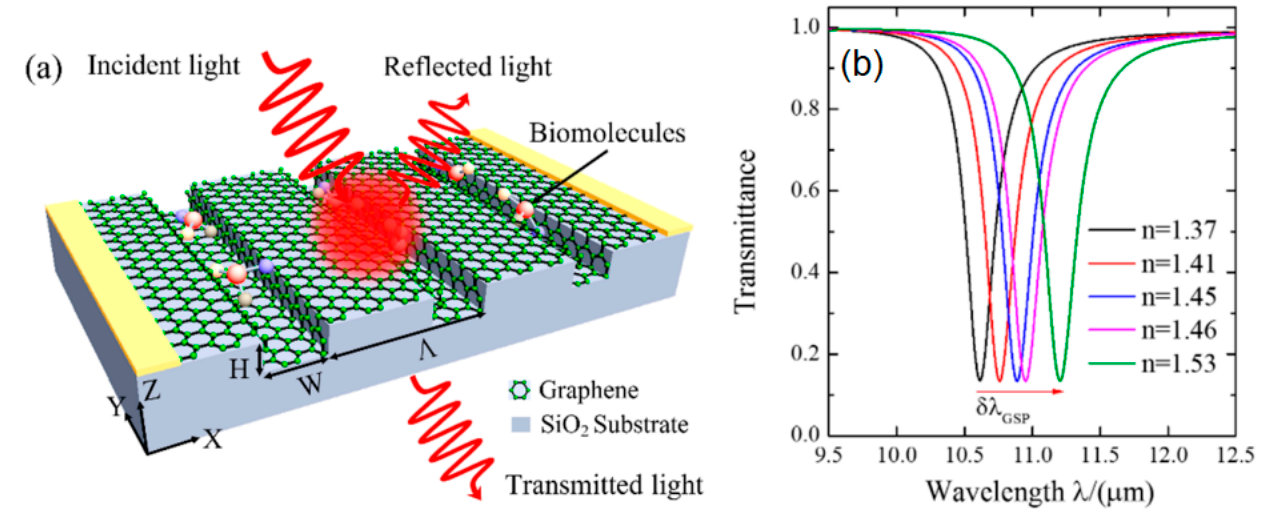
Figure 18. ( a ) Schematic of the conformal graphene-decorated nanofluidic channel (CGDNC) infrared sensor. ( b ) Investigation of sensor sensitivity based on data on the transmittance spectrum (adapted with permission from Reference [77], copyright MDPI).